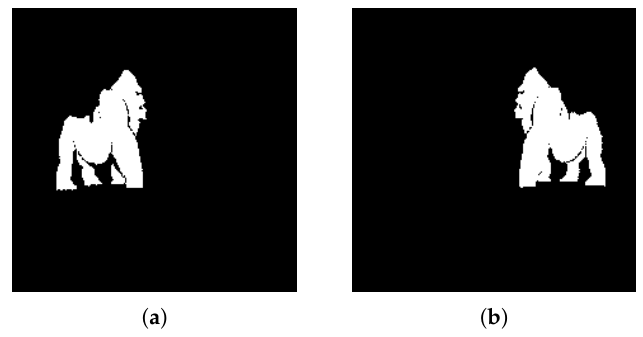
Figure 15. Experiment E extracted regions ( a ) Region A; ( b ) Region B.